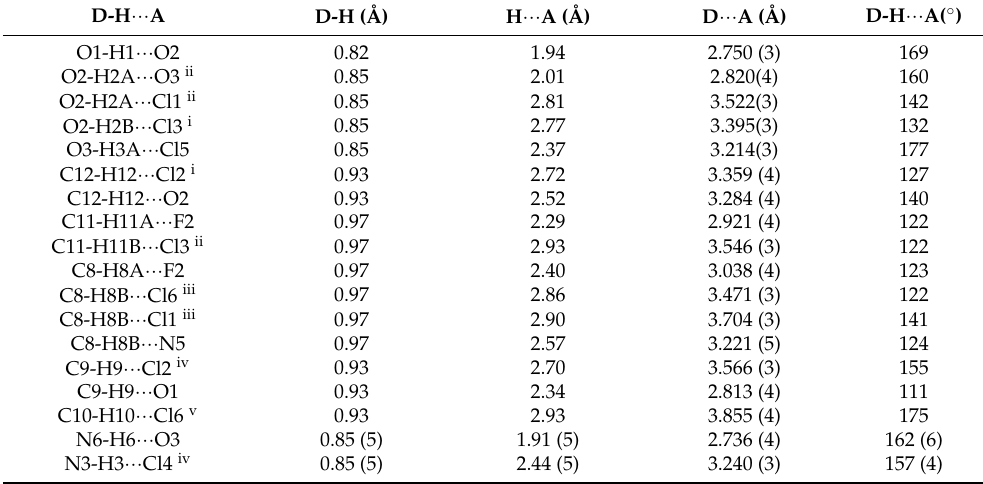
Table 2. Intermolecular interactions in (H2Fluconazole).SnCl 6 .2H 2 O.